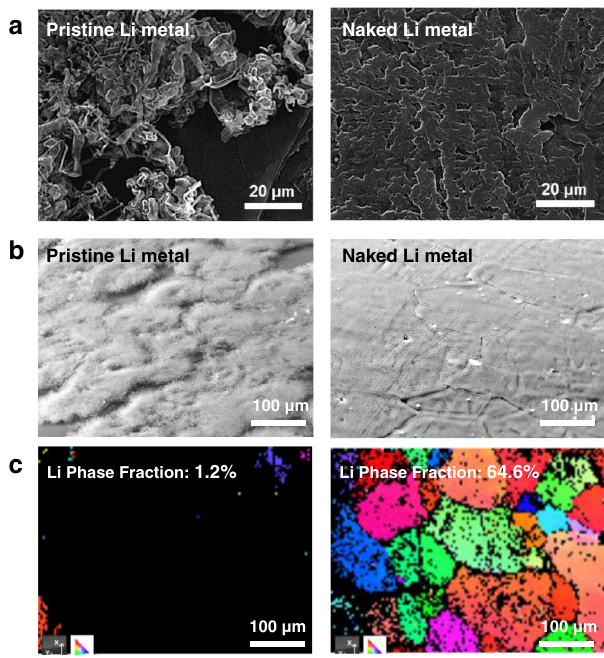
Fig. 4 | Effect of naked Li surface on the morphology of the Li deposit. a SEM images of the pristine (left) and naked (right) Li metal foils after galvanostatic electrodeposition at 1mAcm − 2 with 1mAh cm − 2 . b Slanted SEM images and the corresponding c EBSD images of the pristine (left) and naked (right) Li metal foils after galvanostatic electrodeposition at 1mAcm − 2 with 1mAh cm − 2